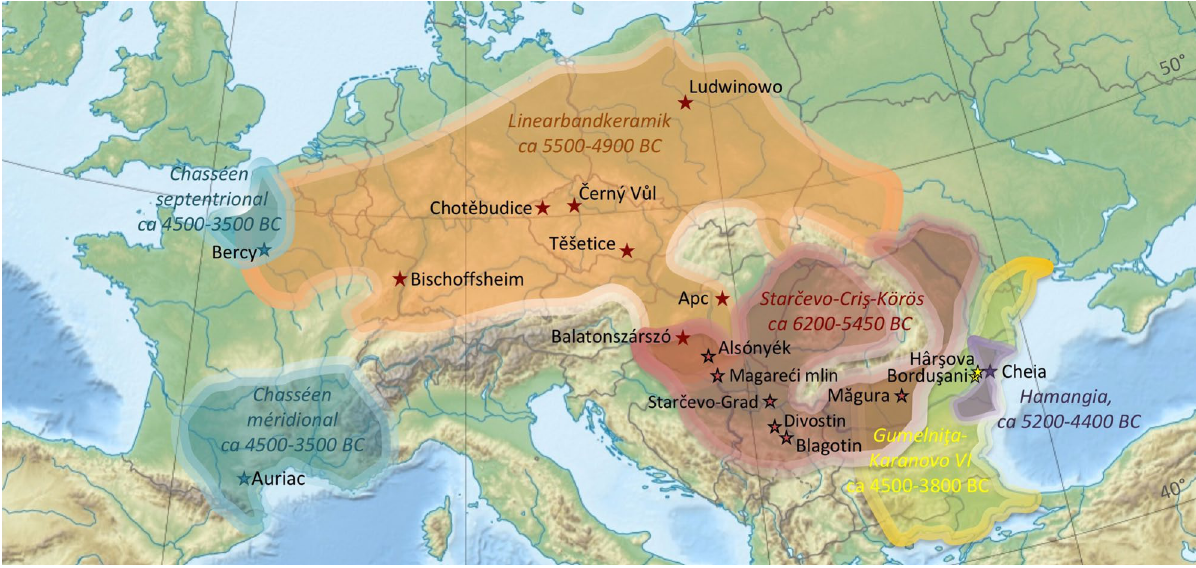
Figure 1. Location of the sites included in the study and their cultural affiliation (Europe relief map by Alexrk2, CC BY-SA 3.0 < https:// creat iveco mmons. org/ licen ses/ by- sa/3.0 > , via Wikimedia Commons; https://